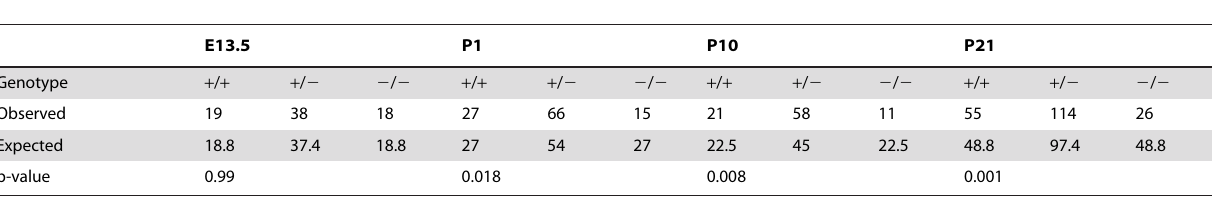
Table 1. Coil 2 / 2 mice display reduced